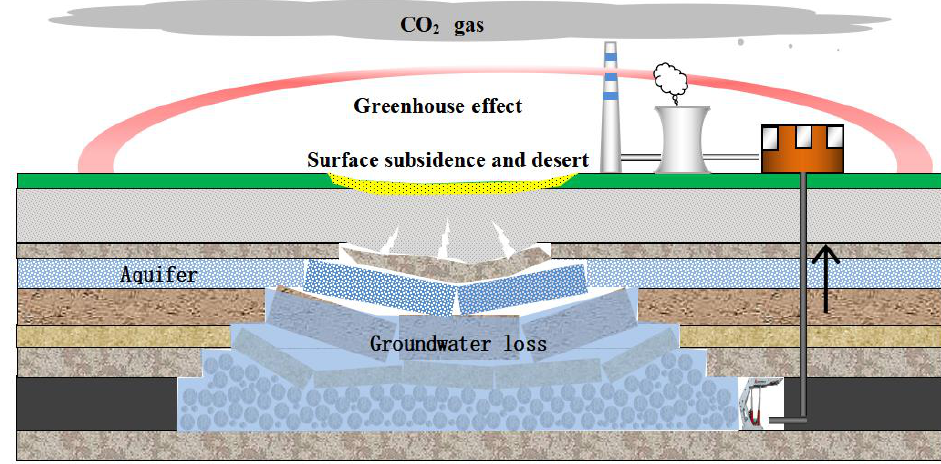
Figure 32. Ecological environmental problems of the large coal power base in Northwest China.